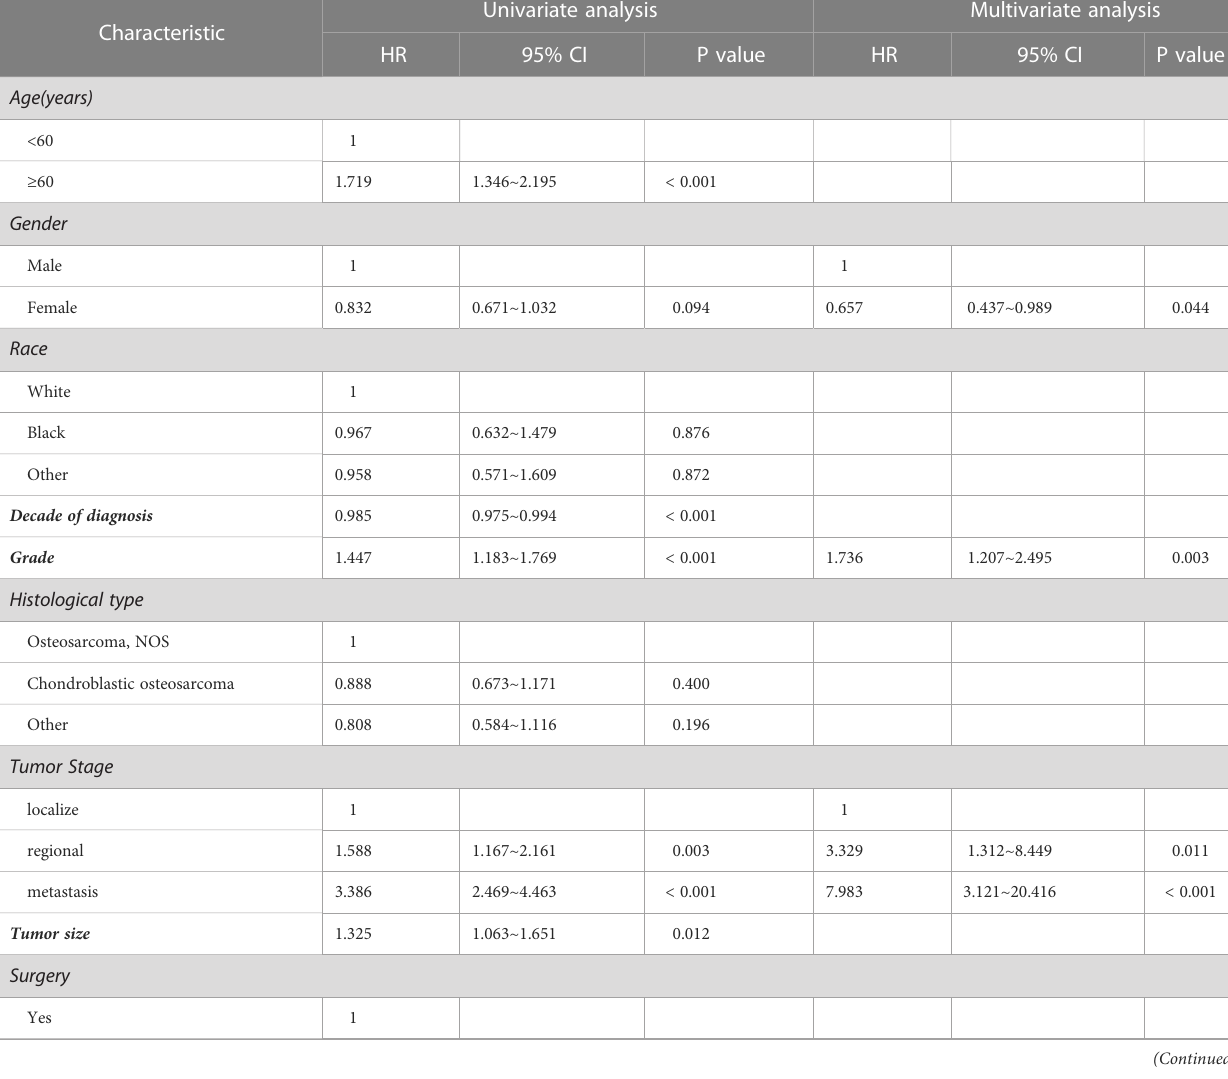
TABLE 3 Univariate and multivariate analysis for clinical factors associated with DSS of spinal osteosarcoma patients.